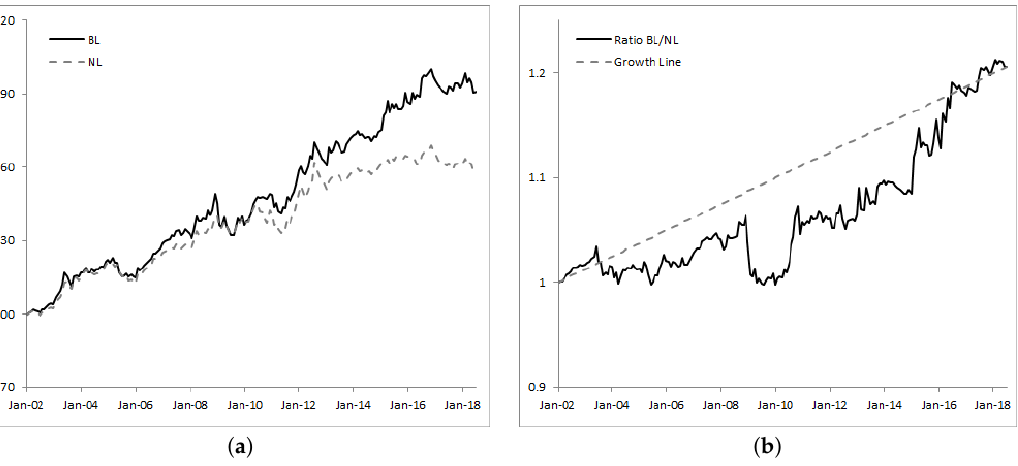
Figure 6. Historical values of the portfolios calculated with both w BL and w NL under the Base Case ( a ) and their ratio ( b